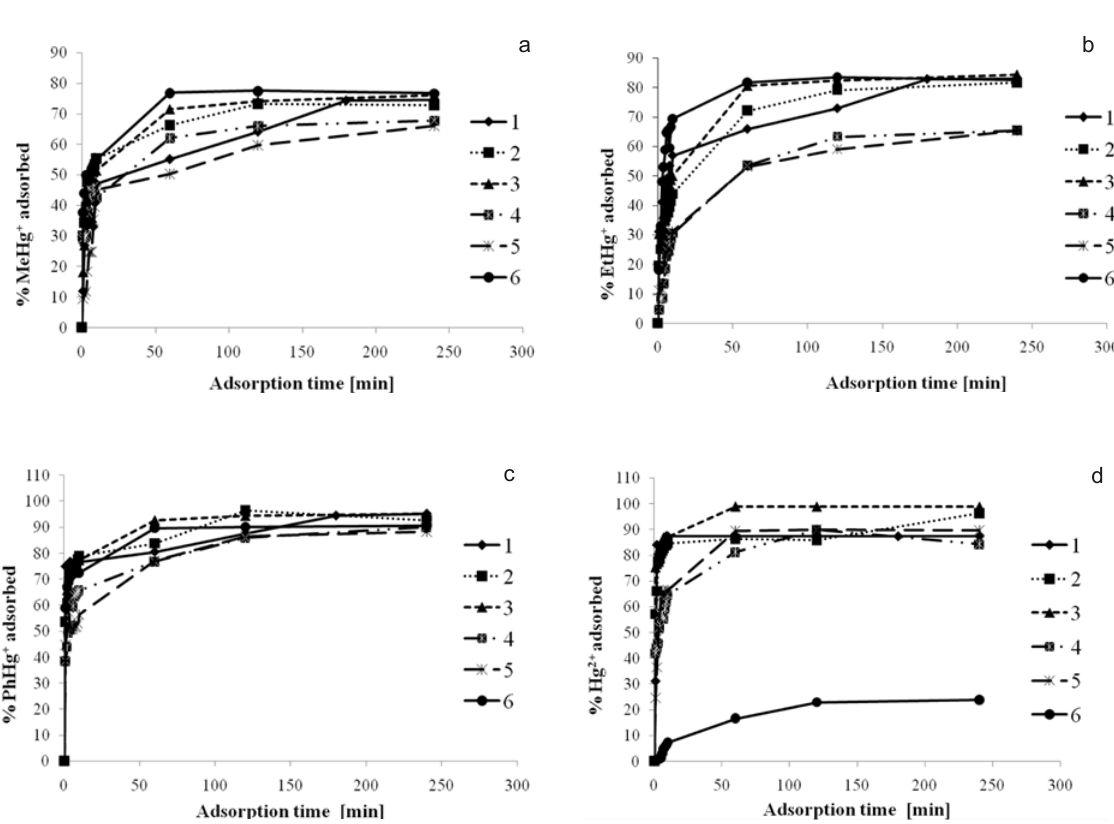
Figure 4. Effect of anions (agitated system, 20 g of ZL 1606 sediment, 250 mL of water, pH 5.2, Hg concentration 0.2 mg L -1 , T = 22.3°C); (1) without anion addition, (2) 0.2 g L -1 NaCl, (3) 10 g L -1 NaCl, (4) 0.2 g L -1 sulfate, (5) 0.05 g L -1 sulfate, (6) 0.2 g L -1 sulfide